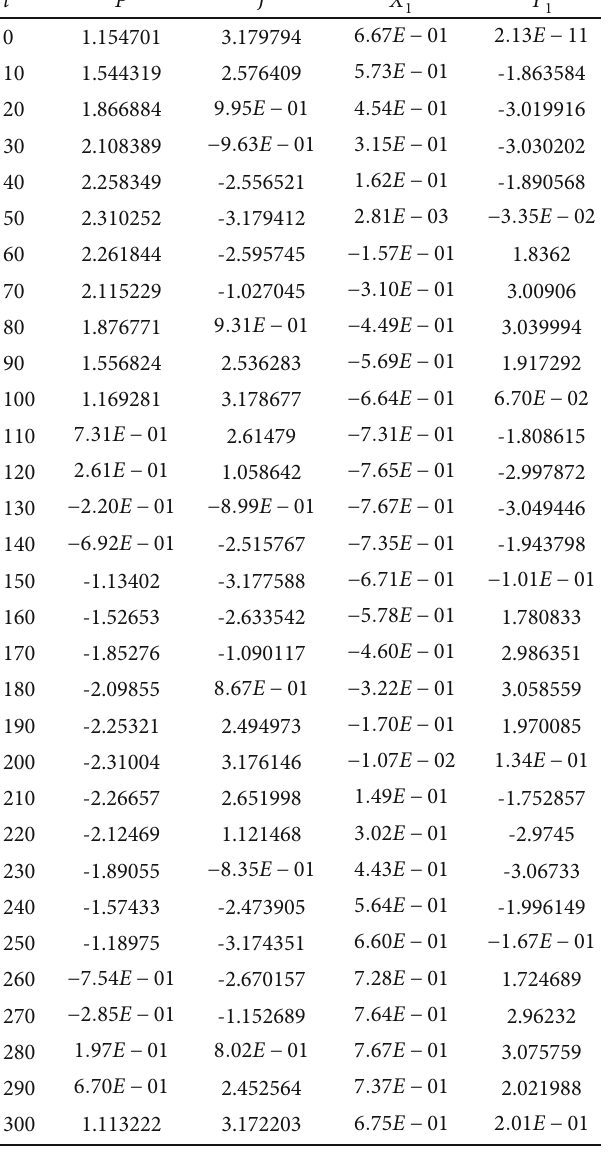
Table 2: The numerical solutions when ω = 1/3 .